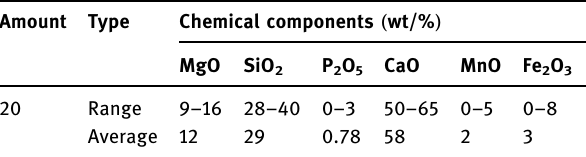
Table 6: Components of phase